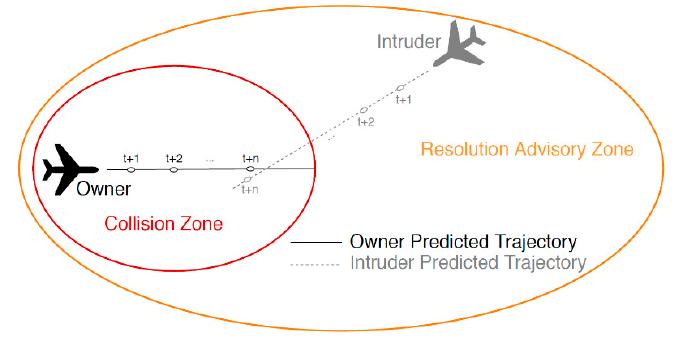
Figure 1. Encounter scenario